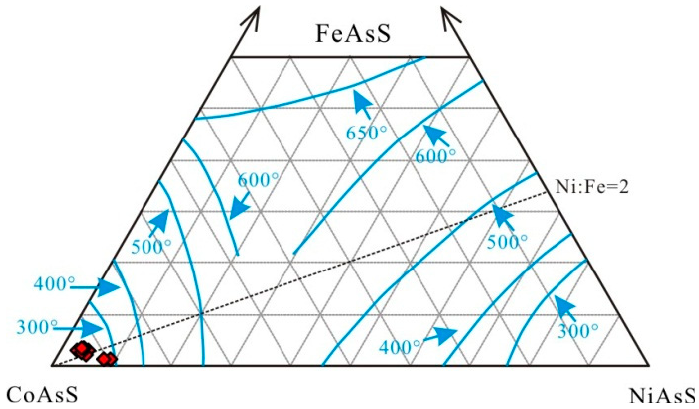
Figure 11. Compositions of cobaltite in the system of CoAsS-FeAsS-NiAsS, mol % (after [44]).